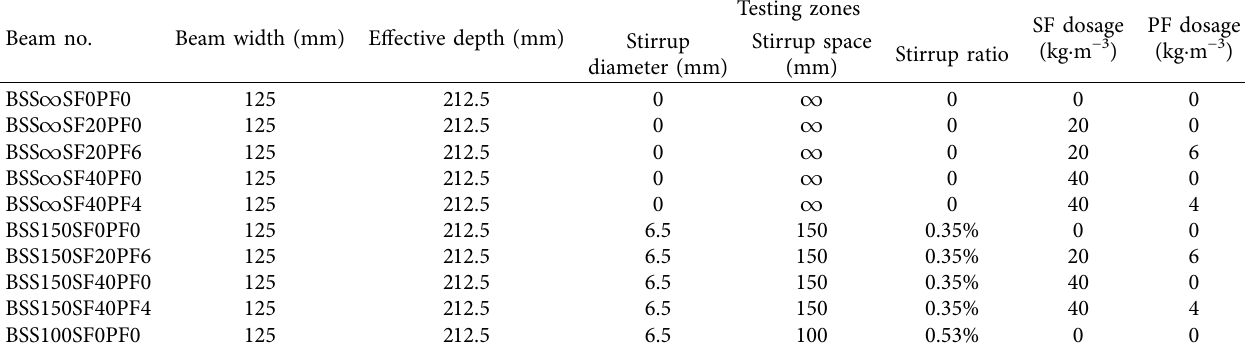
Table 1: Te parameters of beam.